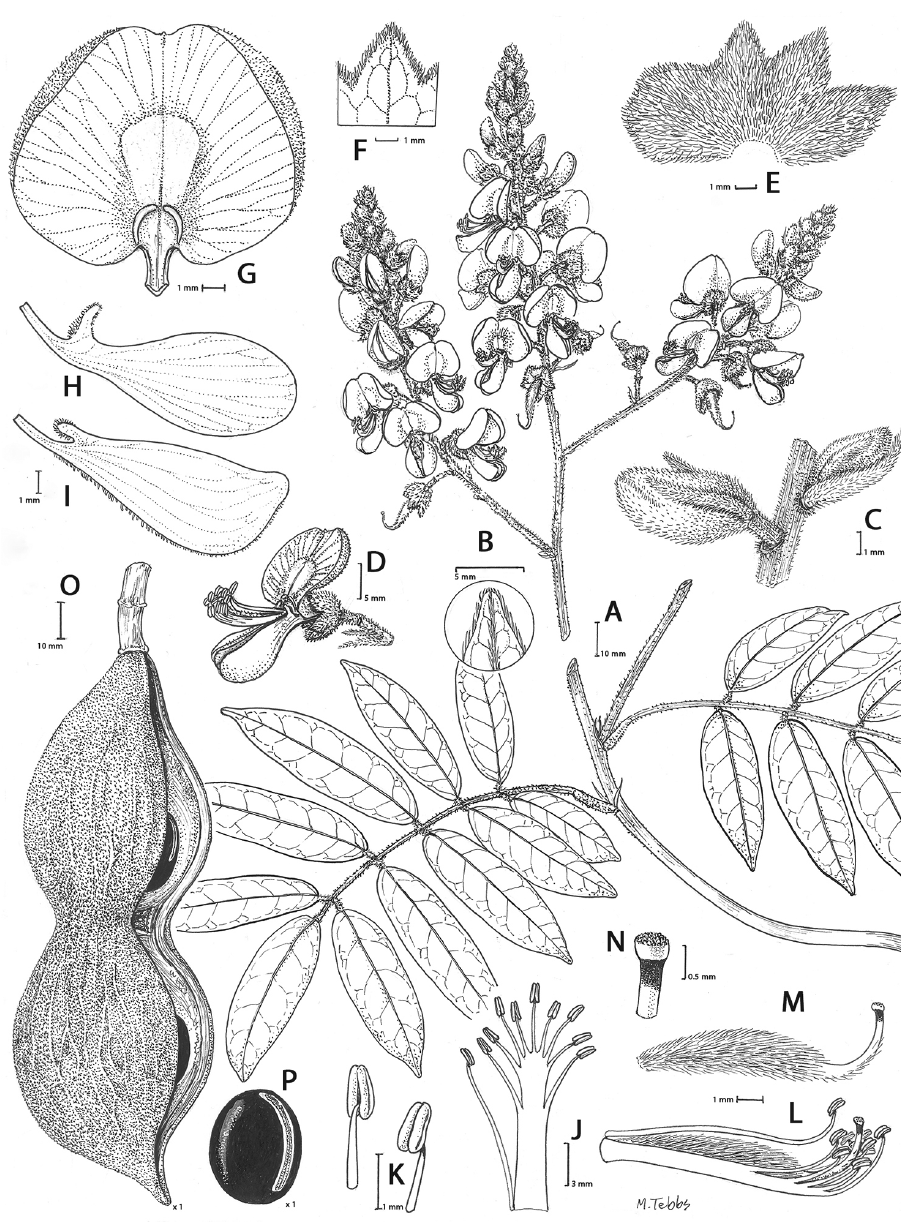
Figure 6. Austrocallerya australis (Endl.) J.Compton & Schrire. A Habit B leaf and detail of leaflet apex C flower buds with bract and 2 bracteoles D flower E calyx external surface F calyx detail of inner surface G standard petal inner surface H wing petal I keel petal J staminal column ventral view K stamens dorsal and ventral views L staminal column lateral view M ovary lateral view N stigma O pod P seed angled lateral view (all from Martin 1392). Drawn by Margaret